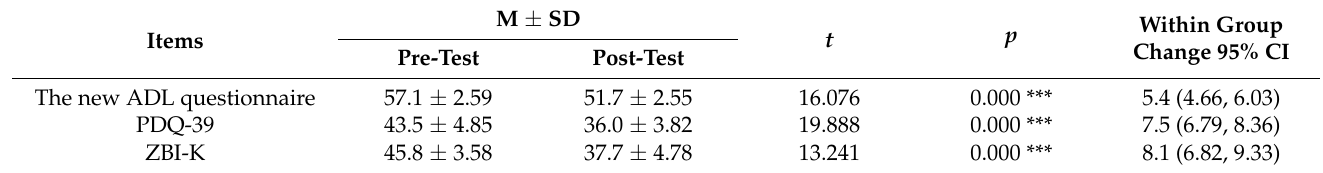
Table 2. Multimodal Rehabilitation